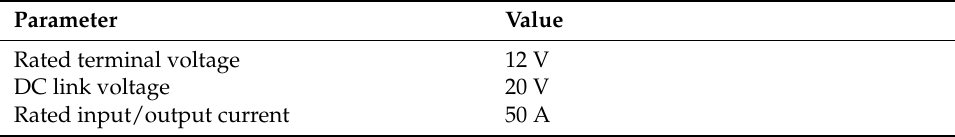
Figure 10. Test set-up with three smart battery modules in the series. Table 6. System